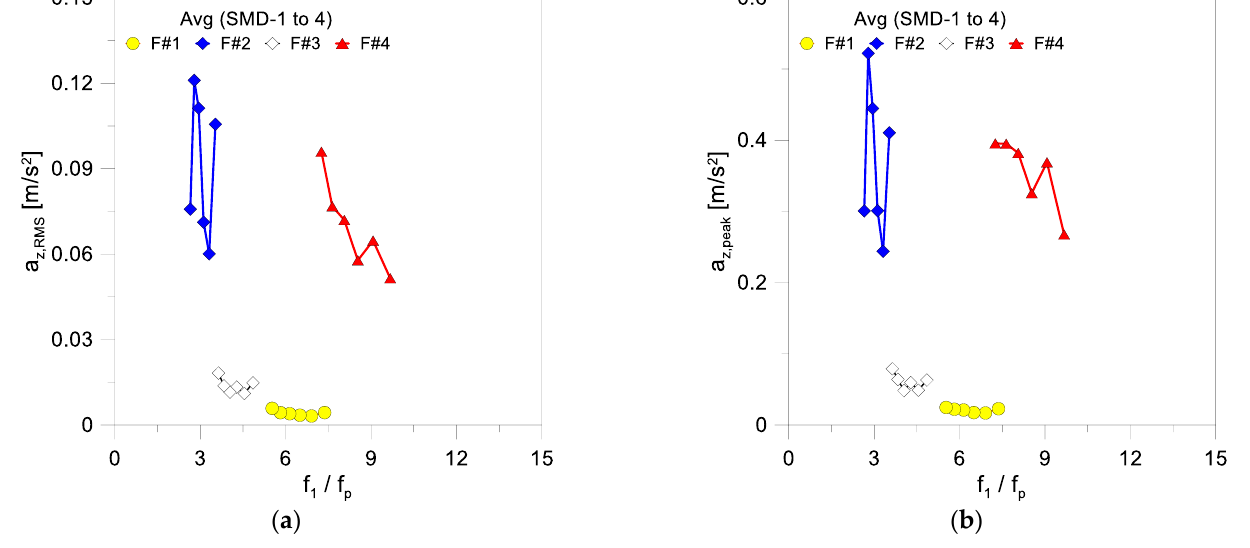
Figure 11. Numerical results for ( a ) RMS acceleration and ( b ) peak acceleration on F#1, F#2, F#3 and F#4 systems, in terms of SMD (average), as a function of vibration frequency f 1 to walking frequency f p ratio (ABAQUS).